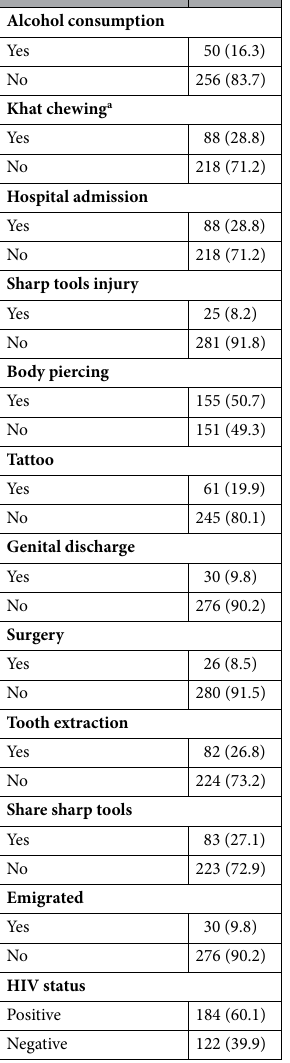
Table 2. Behavioral and health related characteristics of IAHBc individuals in public Hospitals, Eastern Ethiopia, 2017/18 (n = 306). a Khat (Catha edulis) is a flowering plant native to Ethiopia. It contains the alkaloid cathinone, a stimulant, which is said to cause excitement, loss of appetite, and